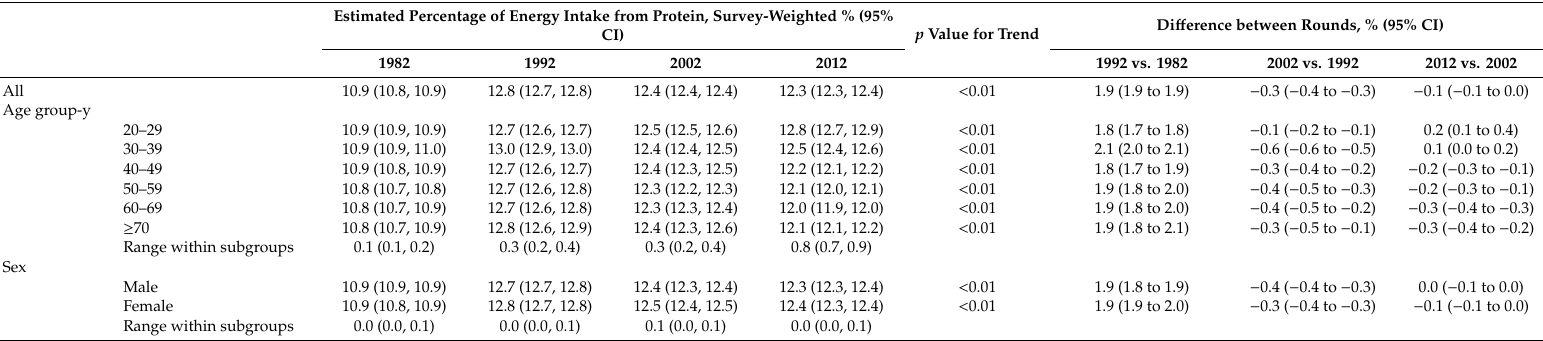
Table A4. Trends and Disparities in the Estimated Percentage of Energy Intake from Protein of Adults Aged 18 Years or Older by CNNS Round, 1982–2012 1